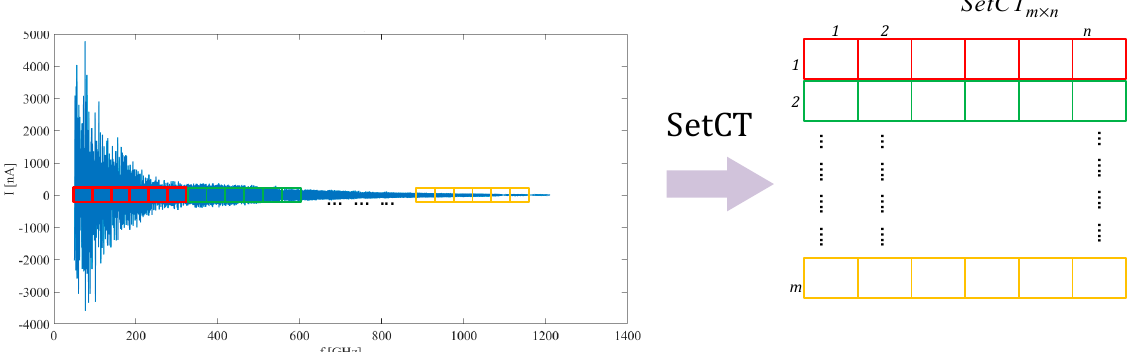
Figure 7. Set cut-technique (SetCT) transformation technique.